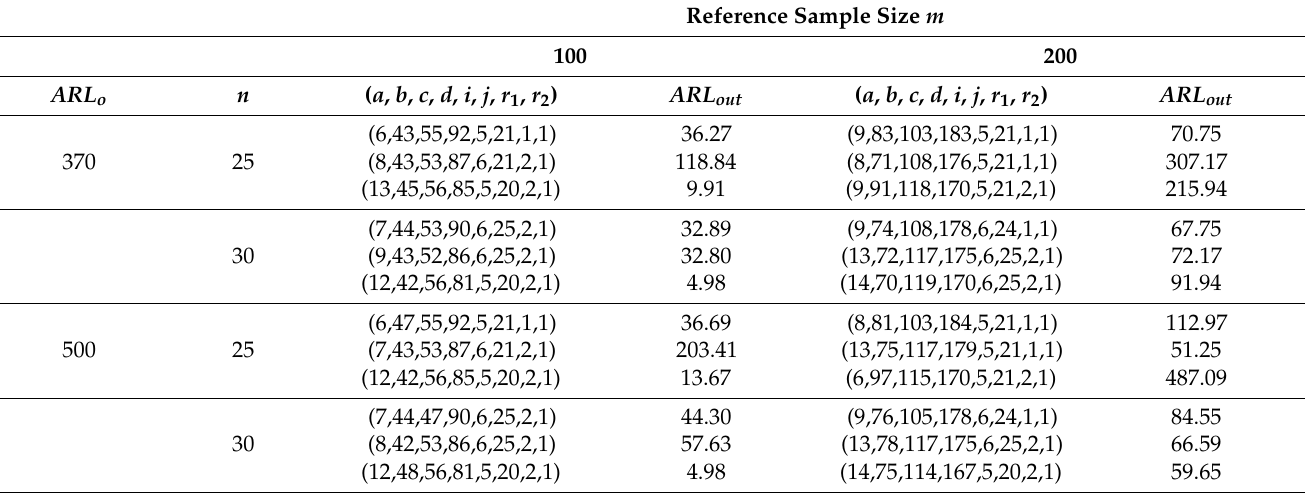
− , C 3 − and C 4 − charts for a given 2 2 2